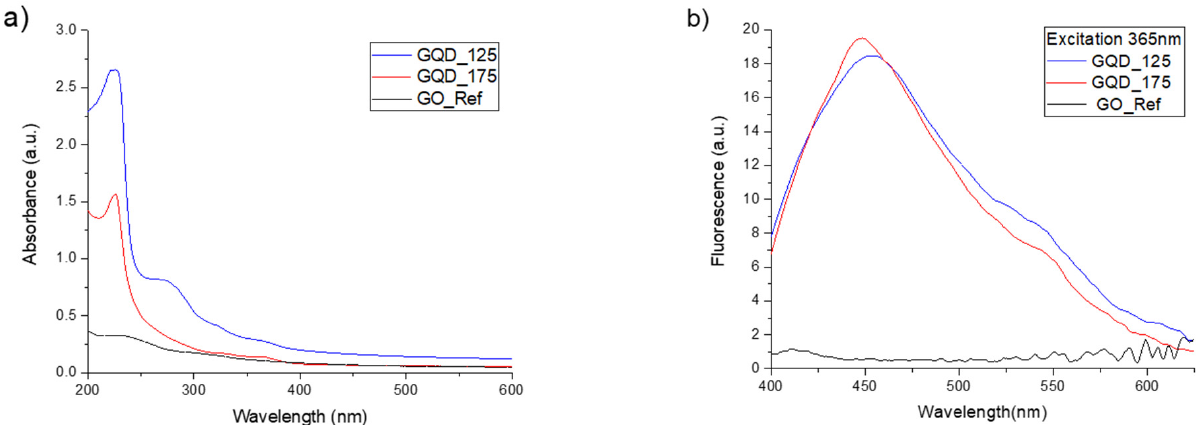
Figure 7. ( a ) UV–Vis absorption spectra and ( b ) fluorescence spectra (under 365 nm excitation) obtained for aqueous suspensions of the GQD_125, GQD_175 and GO_Ref